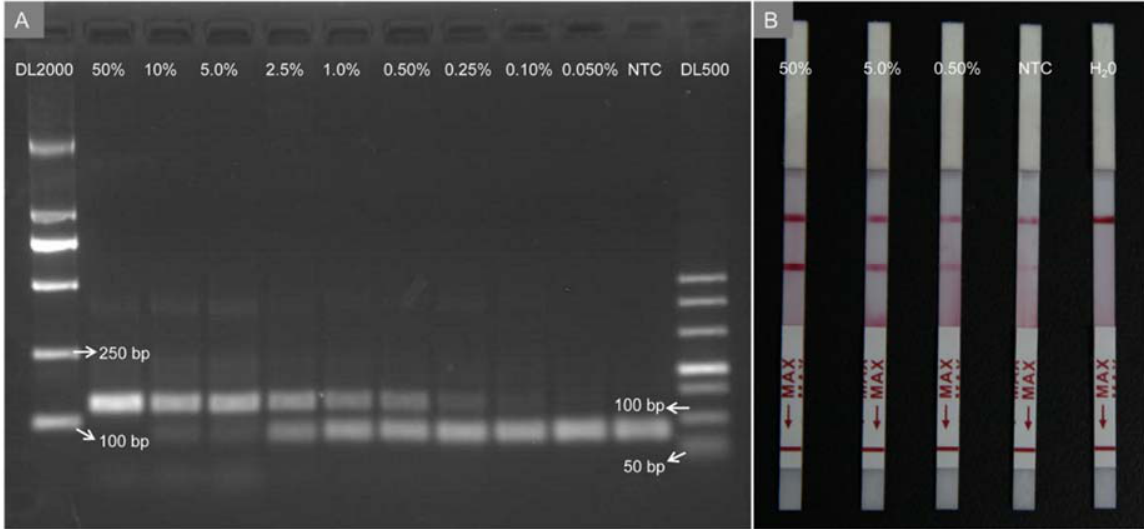
Figure 4. ( A ) Agarose gel electrophoresis and ( B ) lateral flow strip of RPA products from